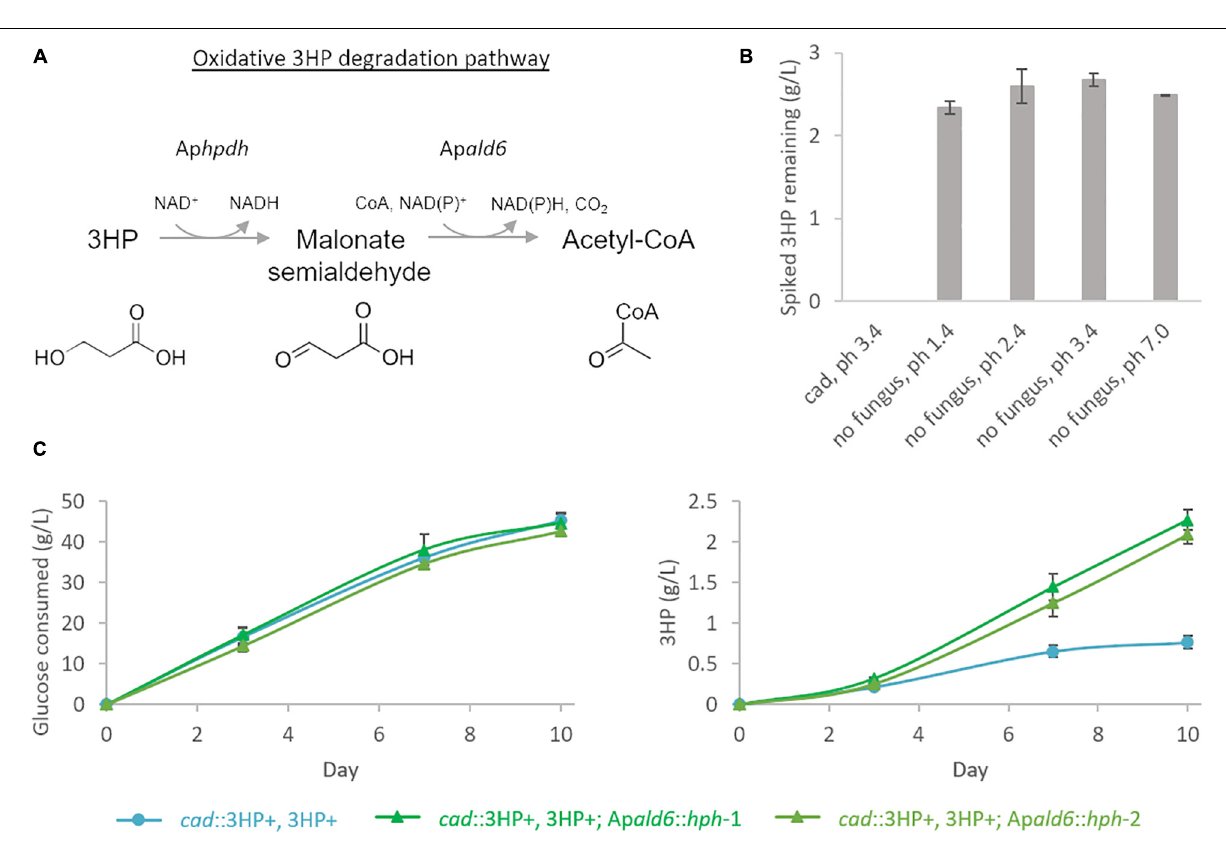
Frontiers in Bioengineering and Biotechnology |